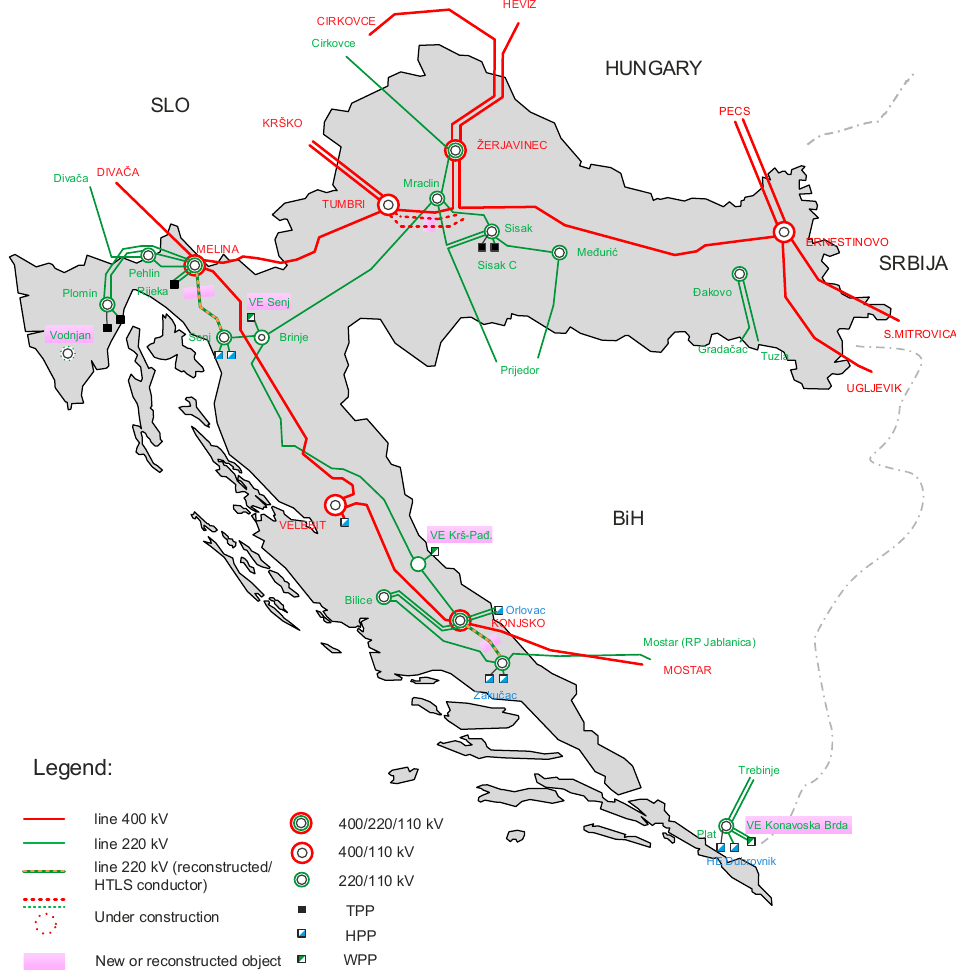
Figure 2. Croatian high-voltage (220 kV and 400 kV) transmission system with its biggest production units (hydro and thermal).